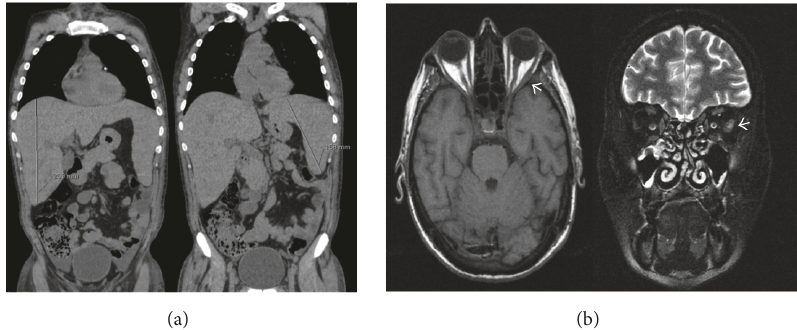
Figure 1: Thoracic-abdominal-pelvic computerized tomography scan showing the hepatosplenomegaly (liver and spleen longitudinal axis of 209 cm and 158 cm, resp.), without other significant abnormalities (a). Cerebral MR images showing swelling of the left lateral rectus muscle on a T2-weighted image, with no other additional findings (b).